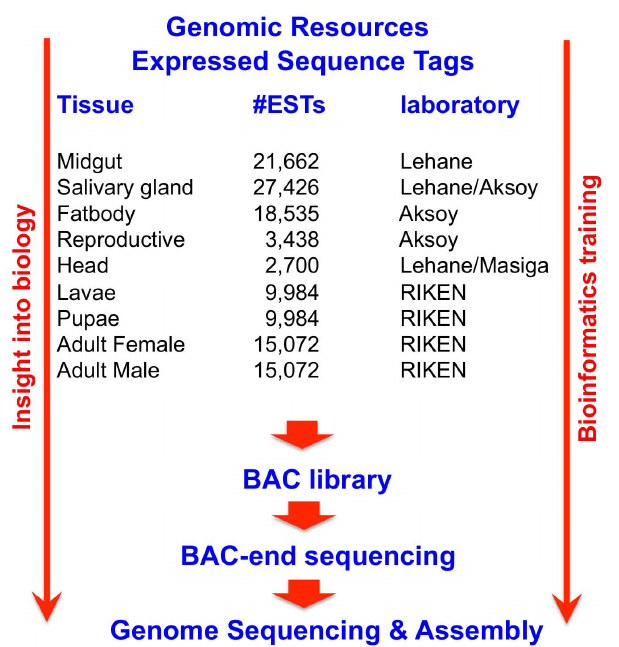
Figure 1. Glossina molecular toolbox to facilitate genomics training. The international Glossina Genome Initiative developed genomic resources including ESTs, a BAC library, and the sequenced Glossina morsitans mortisans genome to facilitate genomic capacity development on the African continent.